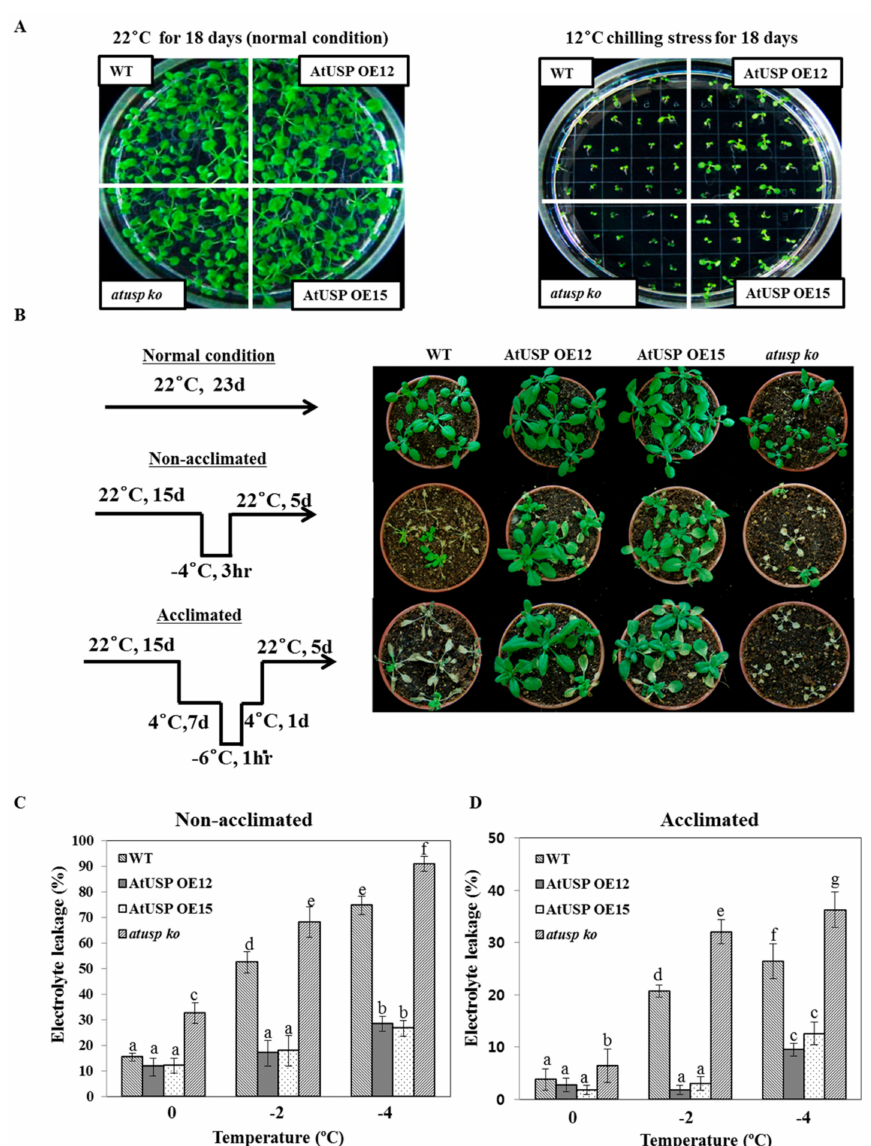
Figure 2. Chilling and freezing tolerance of atusp knock-out and transgenic plants overexpressing AtUSP. ( A ) Effect of chilling stress at 12 ◦ C in WT, AtUSP OE, and atusp plants. Three-day-old seedlings grown on 1/2 MS agar plates were subjected to 12 ◦ C chilling stress for 18 days, and then phenotypes were assessed. (( B ), left panel ) The scheme of cold treatment of WT, AtUSP OE, and atusp plants were treated with cold temperatures as shown in the schematic ( left panel ). For non-acclimated cold treatment, 15-day-old seedlings grown in soil at 22 ◦ C were transferred to − 4 ◦ C for 3 h, and then returned to 22 ◦ C for recovery. For acclimated cold treatment, 15-day-old seedlings grown in soil at 22 ◦ C were subjected to 4 ◦ C for 7 days, transferred to − 6 ◦ C for 1 h, transferred to 4 ◦ C for 1 day, and finally restored to 22 ◦ C for recovery ( right panel ). The cold-treated Arabidopsis plants were photographed after 5 days of recovery. ( C , D ) Electrolyte leakage from leaves of WT, AtUSP OE, and atusp plants after exposure to temperature ranges from 0 to − 4 ◦ C. Simplified electrolyte leakage assay was described in Figure S3 of Supplemental Materials and Materials and Methods. Experiments were performed with at least three biological replicates. All values are means for three replicates ± SE. To compare differences between treatments, data were analyzed using one-way ANOVA and Tukey’s test. Different letters indicate significant differences among the plant lines ( p <